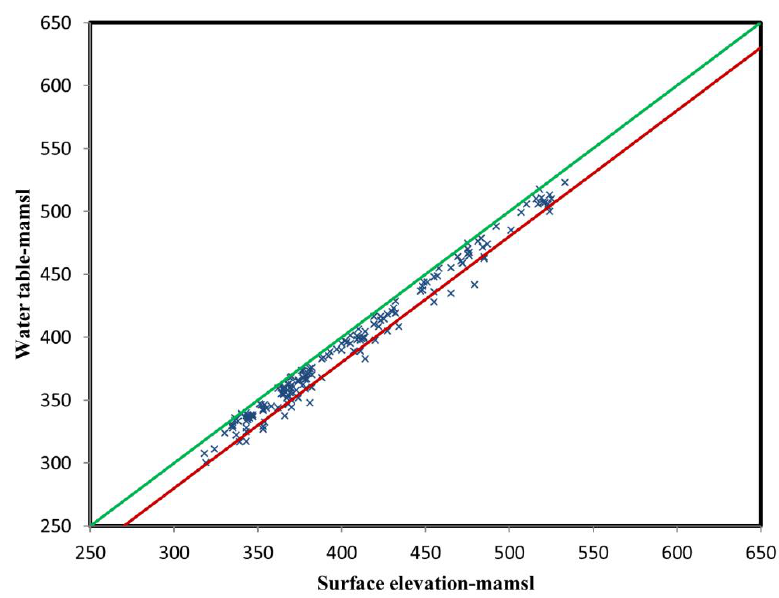
Figure 6. Scatter plot between surface elevation and water table. The blue stars are water table field data, the green line represents surface elevation and the red line corresponds to surface elevation minus 20 m.